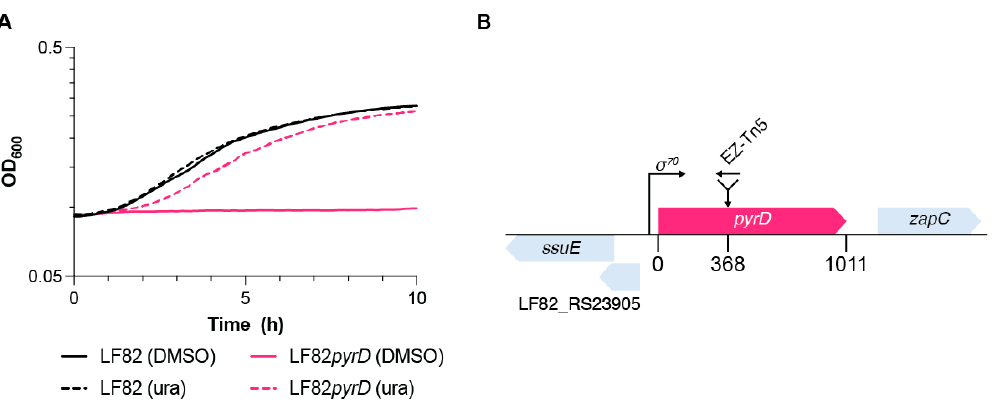
Figure 1. ( A ) Growth curves for LF82 (black) and LF82 pyrD:: Tn5 (LF82 pyrD magenta) in acid medium mimicking the macrophage environment, either in the presence of 0.25 mM uracil (dashed lines) or 0.25% dimethyl sulfoxide DMSO (solid lines); ( B ) Localization of the EZ-Tn5<R6K γ ori/KAN-2> transposon insertion site in the pyrD gene.